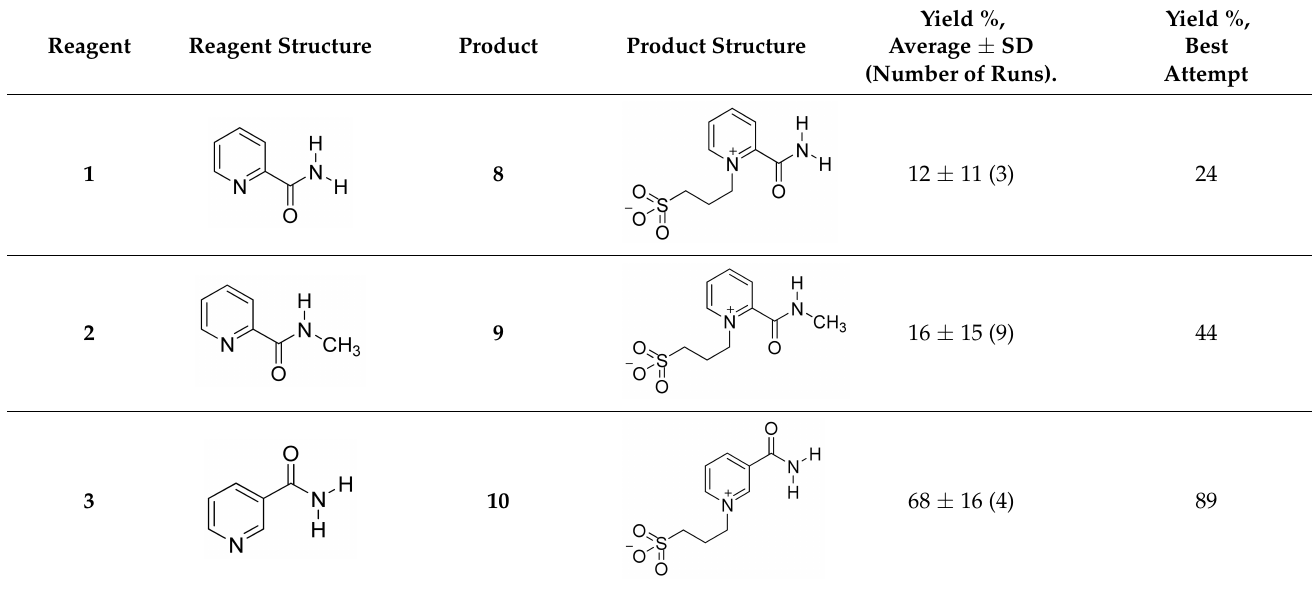
Yield %, Average ± SD (Number of